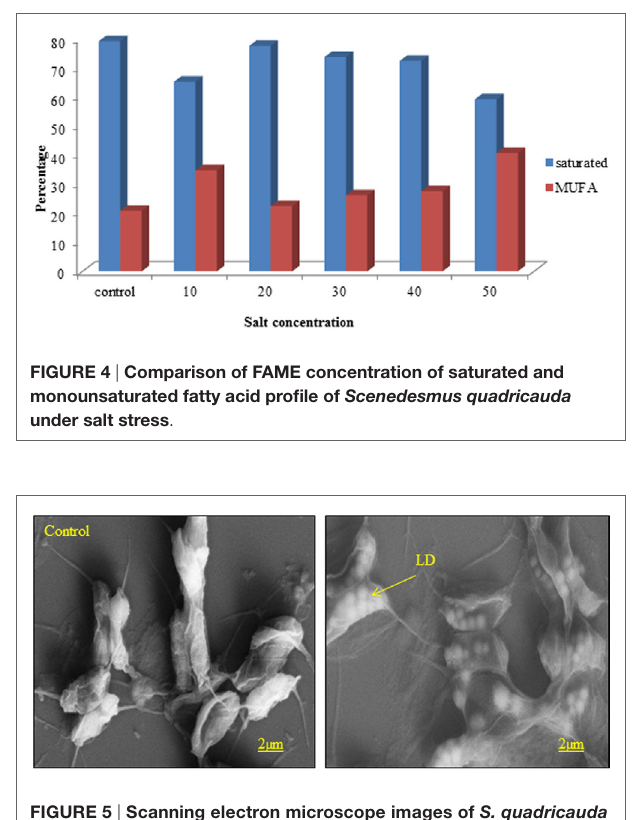
FigUre 5 | scanning electron microscope images of S. quadricauda under salt stress condition (lD) lipid droplet . Scale bars represent 2 μ m size.